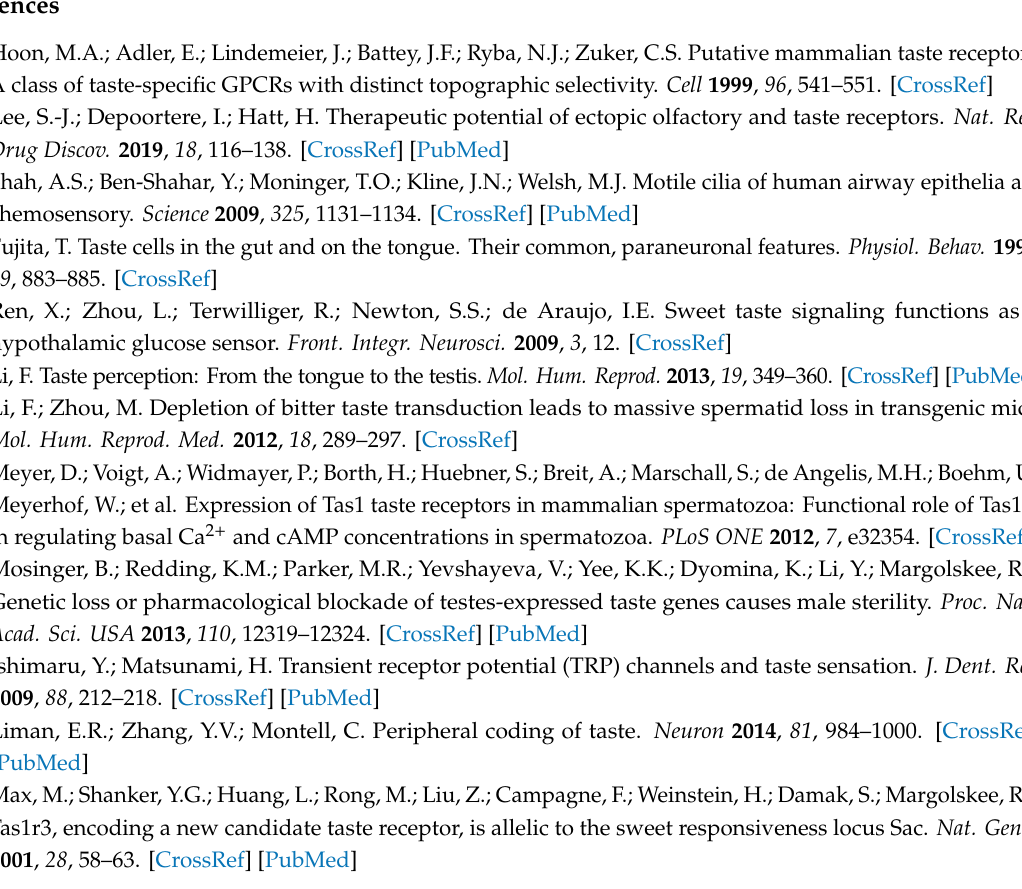
Supplementary Table S1: List of antibodies used in this study; Supplementary Figure S1: Computer-assisted semi-quantitative analysis of the overall relative intensity of the bands from western blot of TAS2R3, TAS2R4, TAS2R14, TAS2R19 and TAS2R43 in extracts of human sperm before (BS) and after in vitro capacitation (CS); Supplementary Figure S2: Computer-assisted semi-quantitative analysis of the overall relative intensity of the bands from western blot of α -Gustducin and α -Transducin in extracts of human sperm before (BS) and after in vitro capacitation